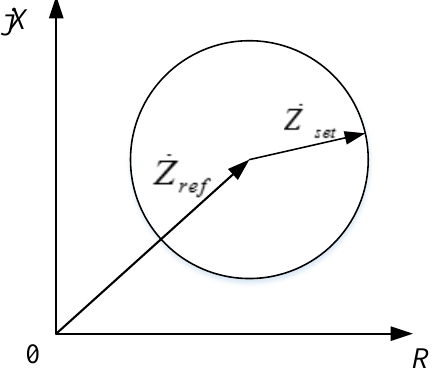
Figure 2. Typical operation characteristics of ELIS in UHVDC system.